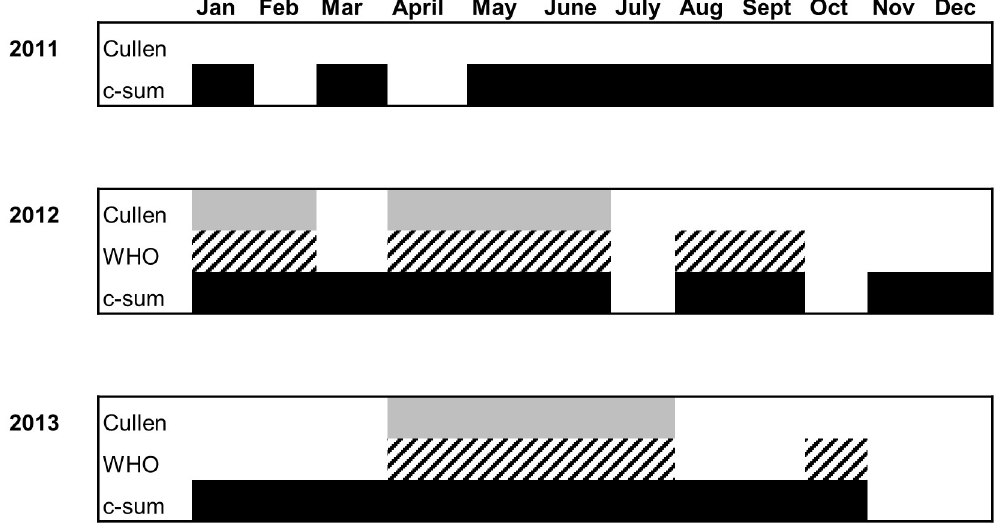
Fig 2. Aberrant months detected by method, 2011–2013. Aberrant months are indicated by shaded blocks for each month: Cullen (light grey), WHO (hatching), and c-sum (black). The WHO method was not applied to 2011 suspected monkeypox case counts due to insufficient historical data.